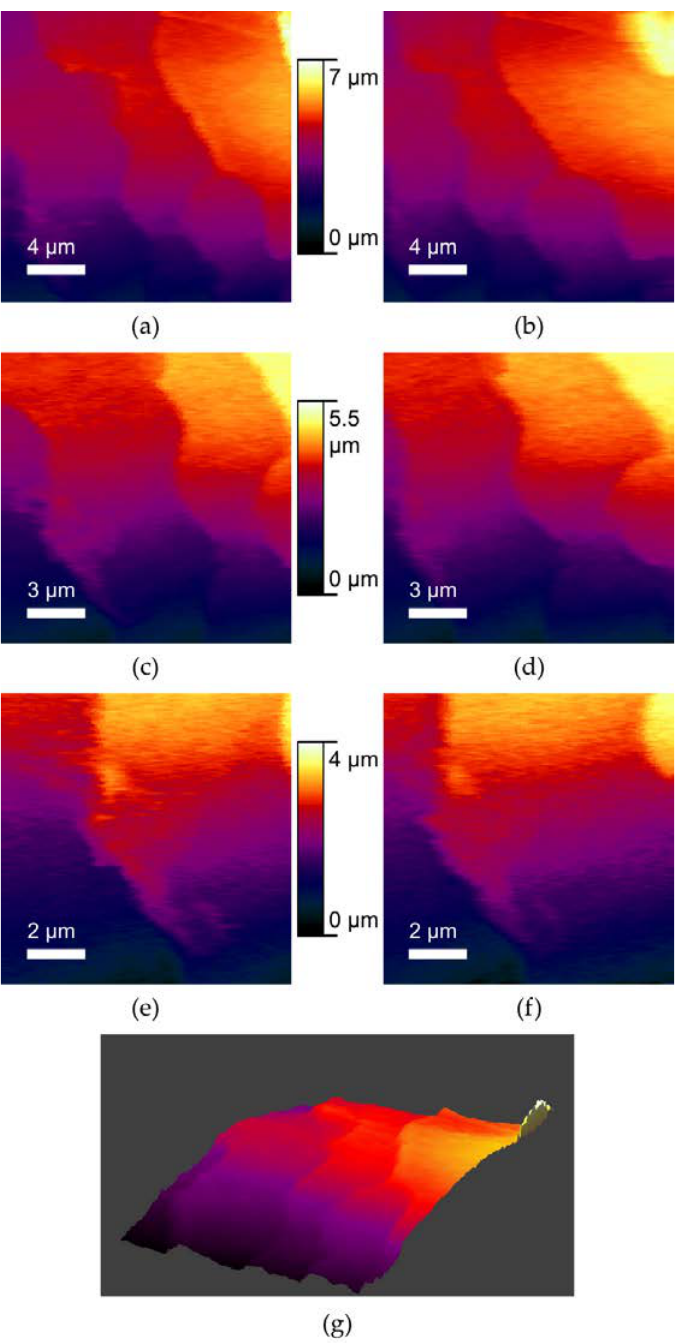
Figure 11. AFM images of author’s hair acquired in constant-force mode: ( a ) Trace image with scan size of 20 µ m × 20 µ m; ( b ) Retrace image of ( a ); ( c ) Trace image with scan size of 15 µ m × 15 µ m; ( d ) Retrace image of ( c ); ( e ) Trace image with scan size of 10 µ m × 10 µ m; ( f ) Retrace image of ( e ); ( g ) 3D surface plot of ( a ).